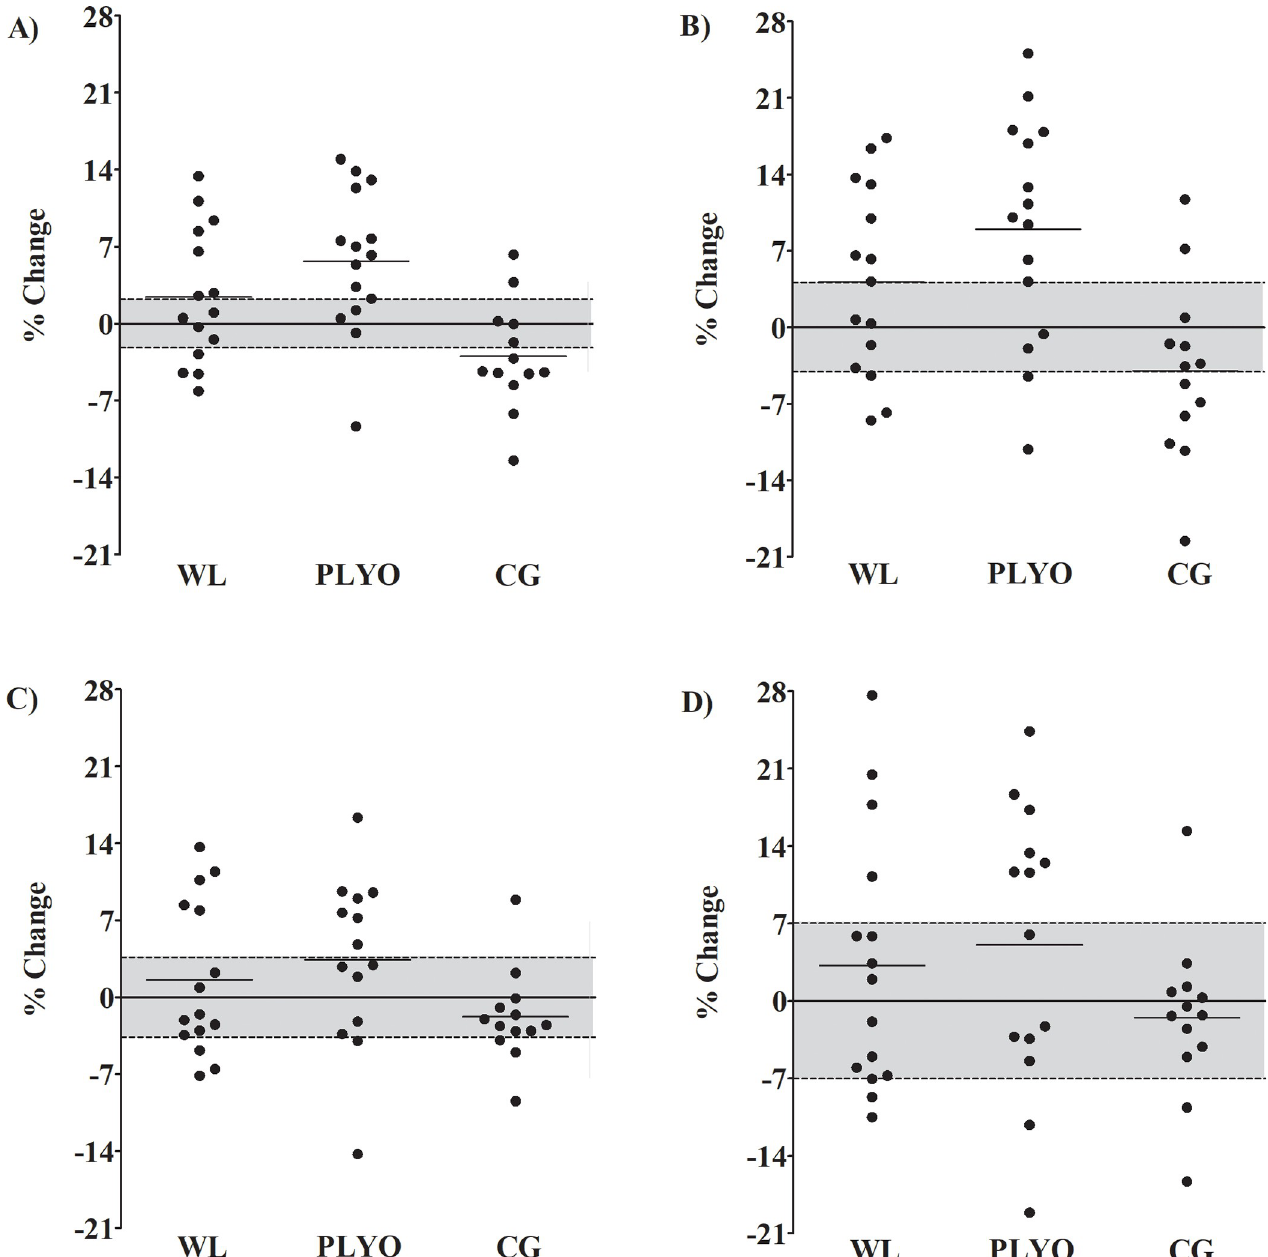
Fig 2. Loaded vertical jumps mean (horizontal lines ____ ) and individual (black circles) percentage changes from pre- to post-training. Grey area represents the coefficient of variation (%). A) Peak power output in the countermovement jump with 60% of the body mass, B) jump height in the countermovement jump with 60% of the body mass, C) peak power output in the countermovement jump with 80% of the body mass, and D) jump height in the countermovement jump with 80% of the body mass. WL = weightlifting derivatives; PLYO = plyometric exercises; CG = control group. For unloaded vertical jumps, both training methods were more effective than CG (Table 3). Between training methods, the PLYO group induced greater improvements than the WL group for PPO and JH in the SJ and PPO in the CMJ (Table 3). In addition to the significant changes occurred only in the PLYO and favorable ES compared to WL group (Table 3), the individual percentage changes above the CV also occurred more frequently for the PLYO